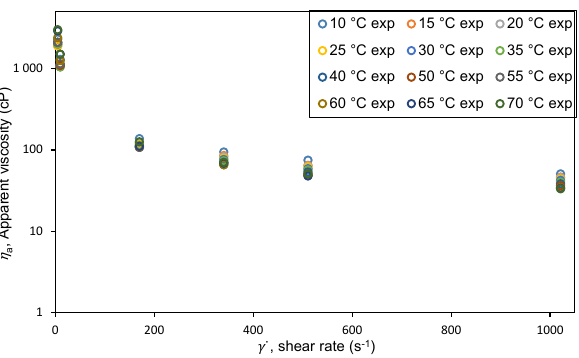
Figure 5: Apparent viscosity vs. shear rate (FANN viscometer read- ings) in the temperature range of 10-70 ∘ C.